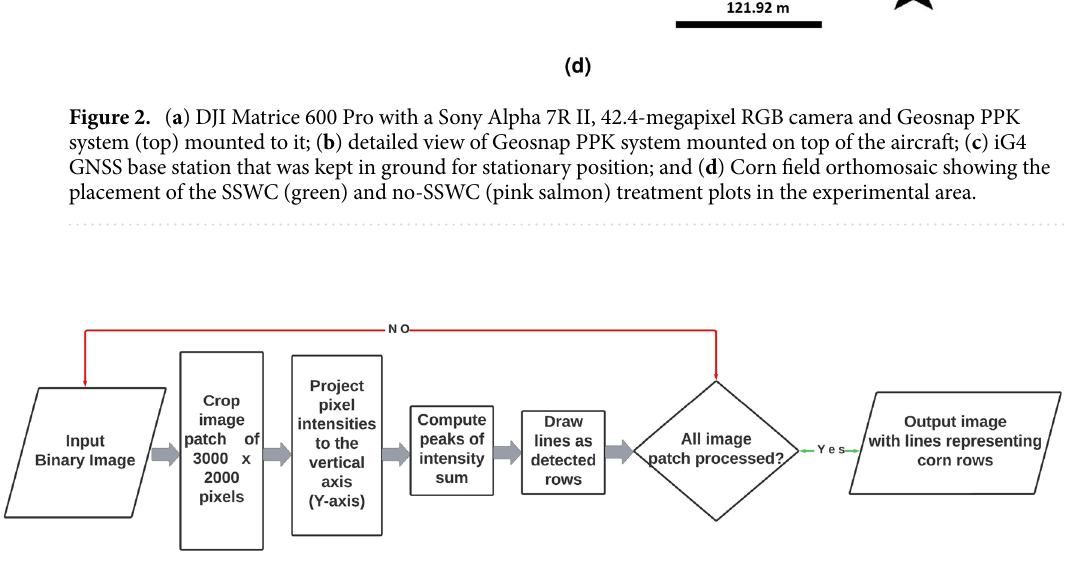
Figure 3. Flow diagram of Corn Row Identification (CRI) algorithm to detect lines over corn rows in binary imagery generated from UAS In this expression, if the ExGI value of a pixel (x,y) is greater than the threshold value of 0.08, then the corre- sponding output pixel g(x,y) is set to 1, indicating that it belongs to the green vegetation (corn rows). Conversely, if the ExGI value of a pixel (x,y) is less than or equal to the threshold value of 0.08, then the corresponding output pixel g(x,y) is set to 0, indicating that it belongs to the background (non-vegetation). This results in a binary image with pixel intensity value 1 for the vegetation (corn rows) and 0 for the remaining background. That binary image was further processed to identify the corn rows. There are a few scientific reasons why the excess green index could be more useful than NDVI in this scenario. First, ExGI is less affected by soil reflectance than NDVI, which can be particularly important during the early growing season when crops are small and soil background is more prevalent in the imagery 64 . NDVI is known to be sensitive to variations in soil background, which can lead to false positives or negatives in vegetation segmentation. ExGI, on the other hand, is less sensitive to soil reflectance and can more accurately differentiate vegetation from the soil. Second, ExG can better differentiate between different types of vegetation than NDVI. This is because NDVI is sensitive only to the chlorophyll content in plants, which can be similar between dif- ferent types of plants. ExGI, on the other hand, is more sensitive to differences in leaf structure and pigments,